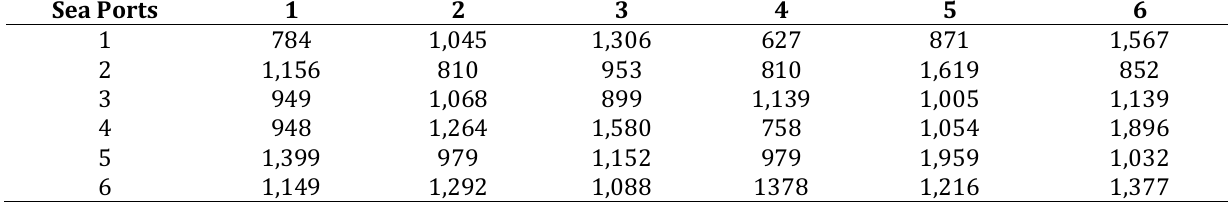
Table 4: 20ft & 40ft Stuffed Shipping Containers available for distribution Sea Ports